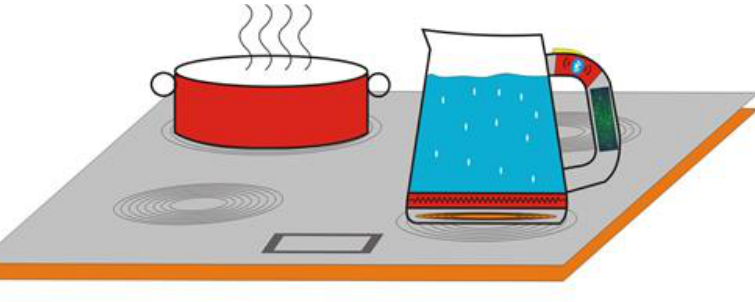
Figure 1. IH cooktop and WPT kettle.